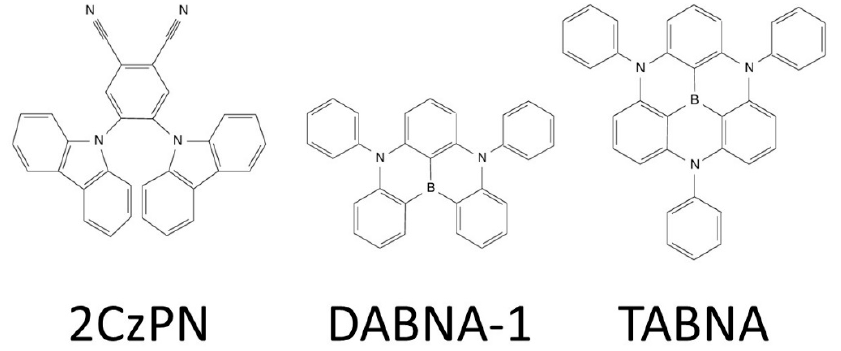
Figure 4. Chemical structure (from left to right) of the 1,2-bis(carbazol-9-yl)-4,5-dicyanobenzene (2CzPN) and the DABNA-1/TABNA triangulene derivatives.